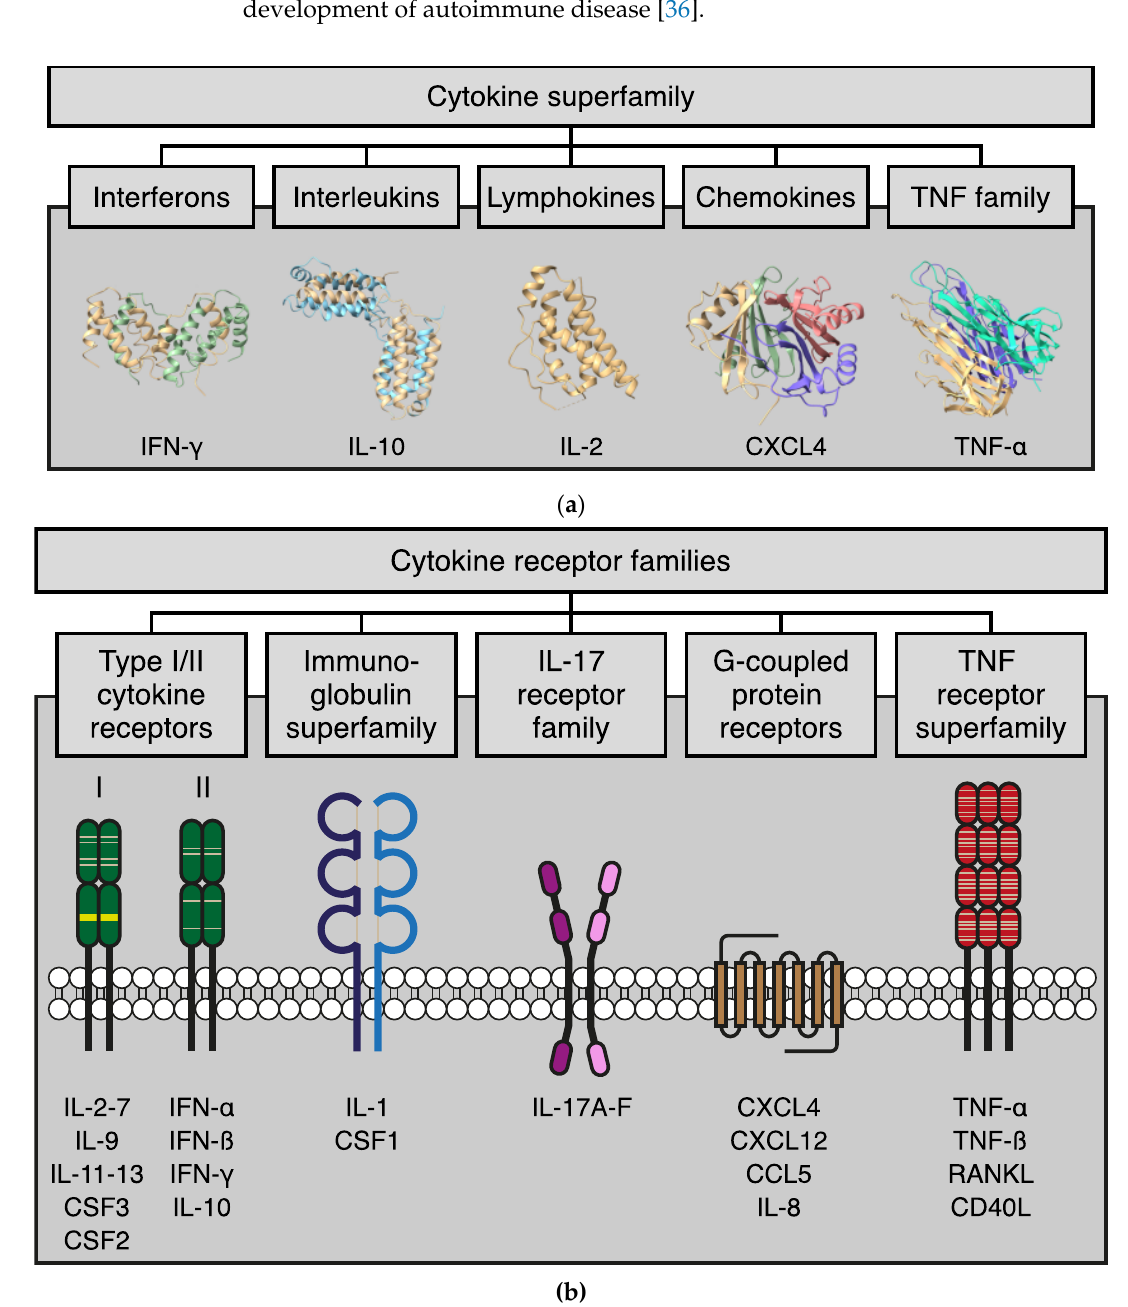
Figure 1. The cytokine protein family. ( a ) Schematic representation of the cytokine superfamily and the main subfamilies. For each subfamily, the structure of a representative member is shown. IFN- γ (PDB: 1HIG); IL-10 (PDB: 2ILK); IL-2 (PDB: 1M47); CXCL4 (PDB: 1F9Q); TNF- α (PDB: 4TSV). ( b ) Schematic representation of the different cytokine receptor families with a cartoon of the general domain structure (in different colors for the different families) and some key cytokine ligands